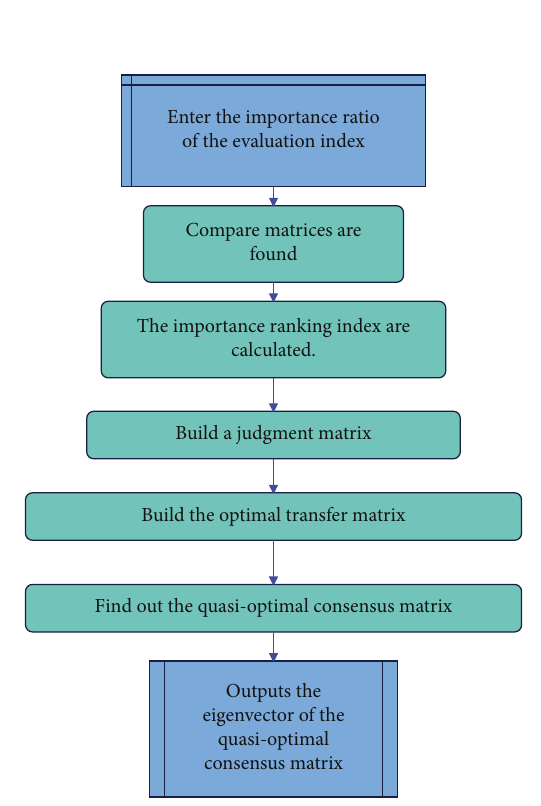
Figure 3: The flow of the improved AHP.